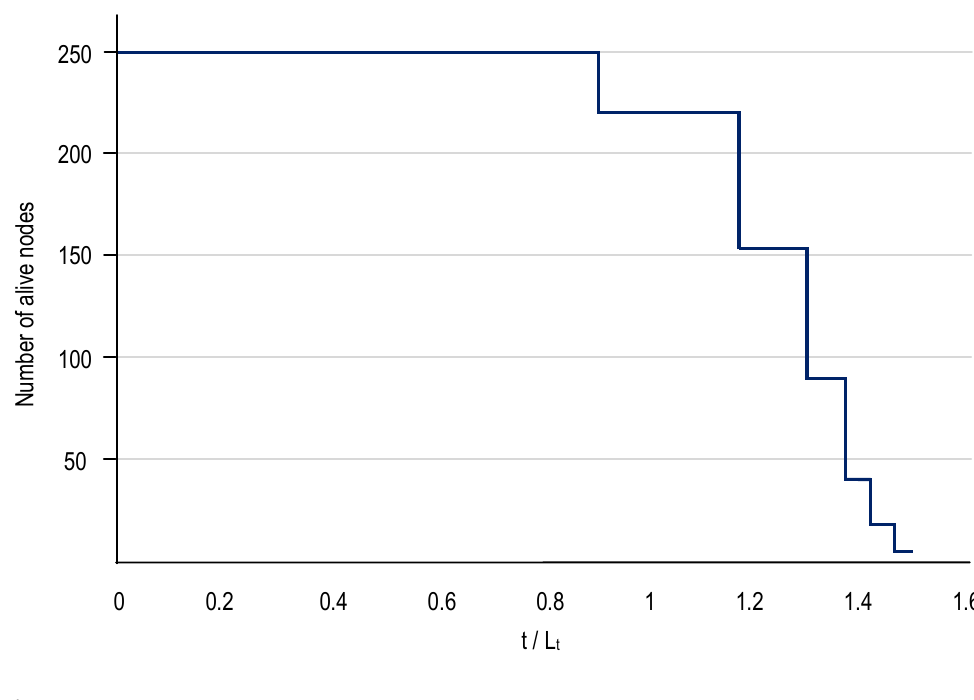
Figure 15. Lifetime in a deployment of 250